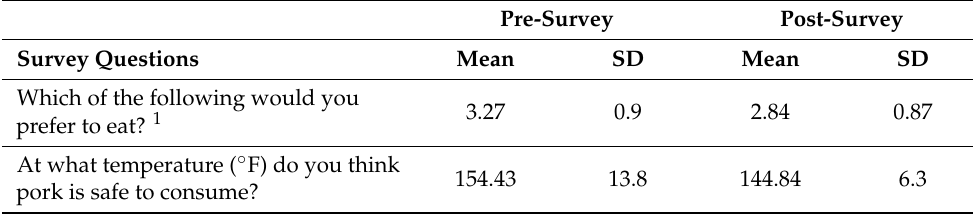
Table 7. Comparison of pre-survey and post-survey questions regarding degree of doneness prefer- ence and safe temperature to consume pork 1